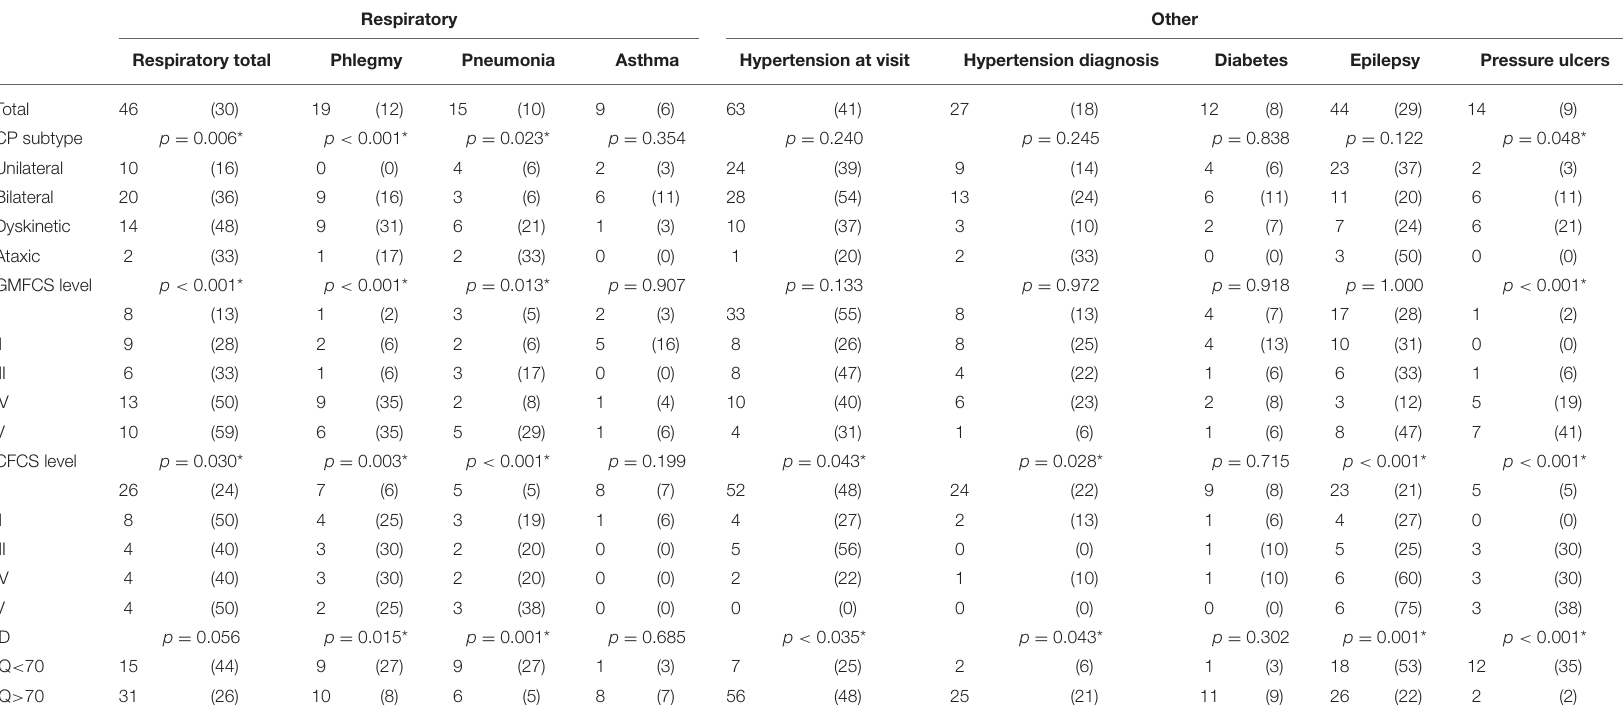
TABLE 2B | Health conditions in adults with CP, by CP subtype, GMFCS level, CFCS level, and ID ( n =